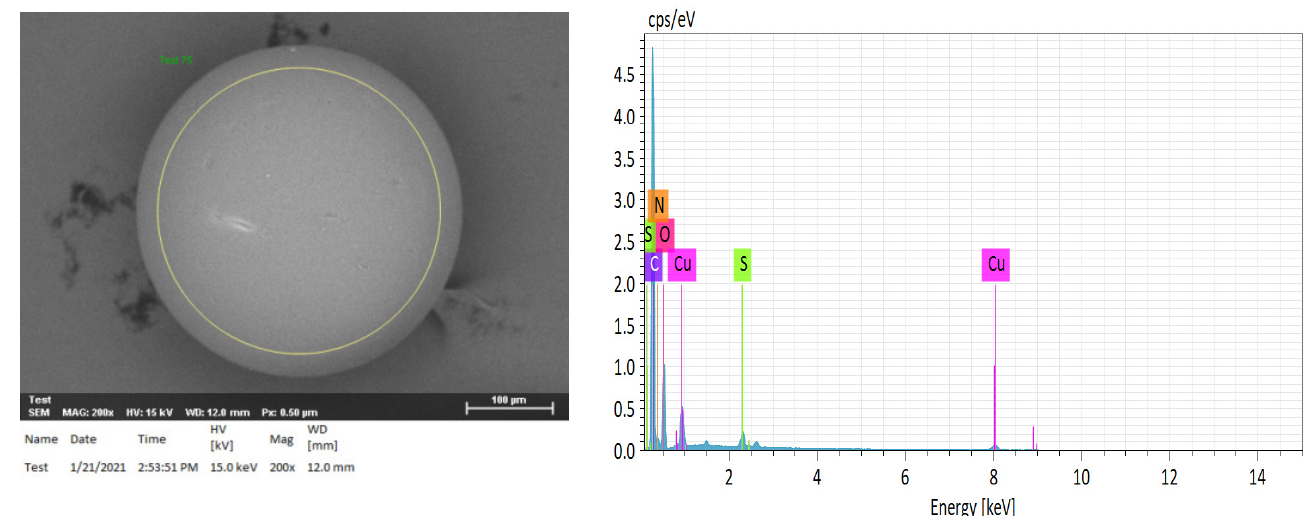
Figure 5. SEM-EDX image of Cu(II) loaded onto H + Dowex-M4195 chelating resin.